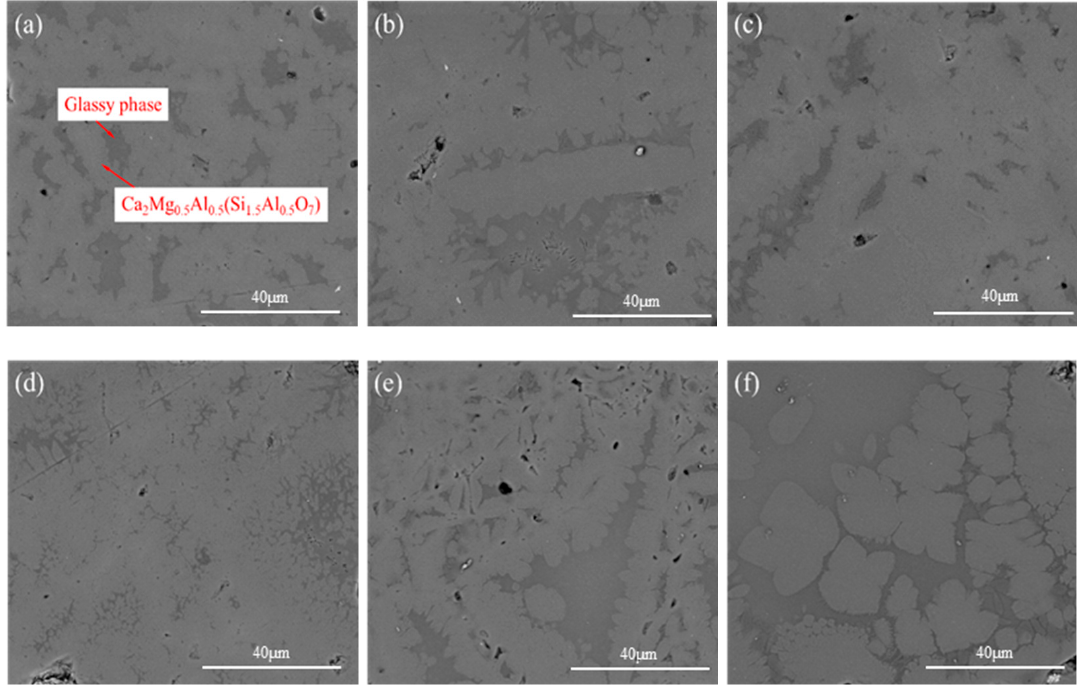
Figure 9. Scanning electron microscopy (SEM) images of the polished glass ‐ ceramics. ( a ) S1, ( b ) S2,